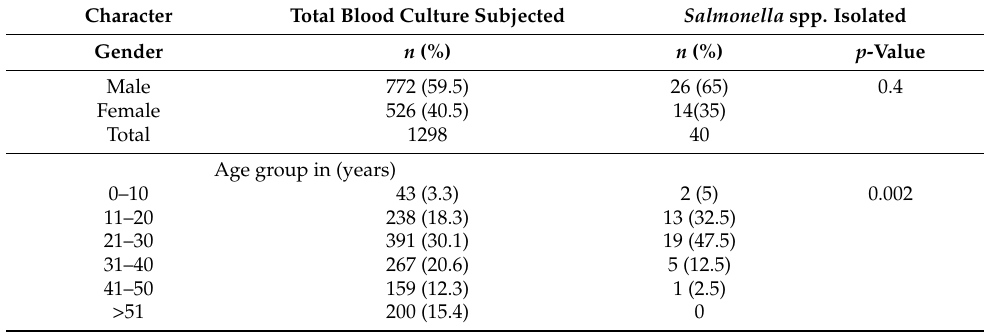
Table 1. Distribution of Salmonella isolates according to age and gender of patients.